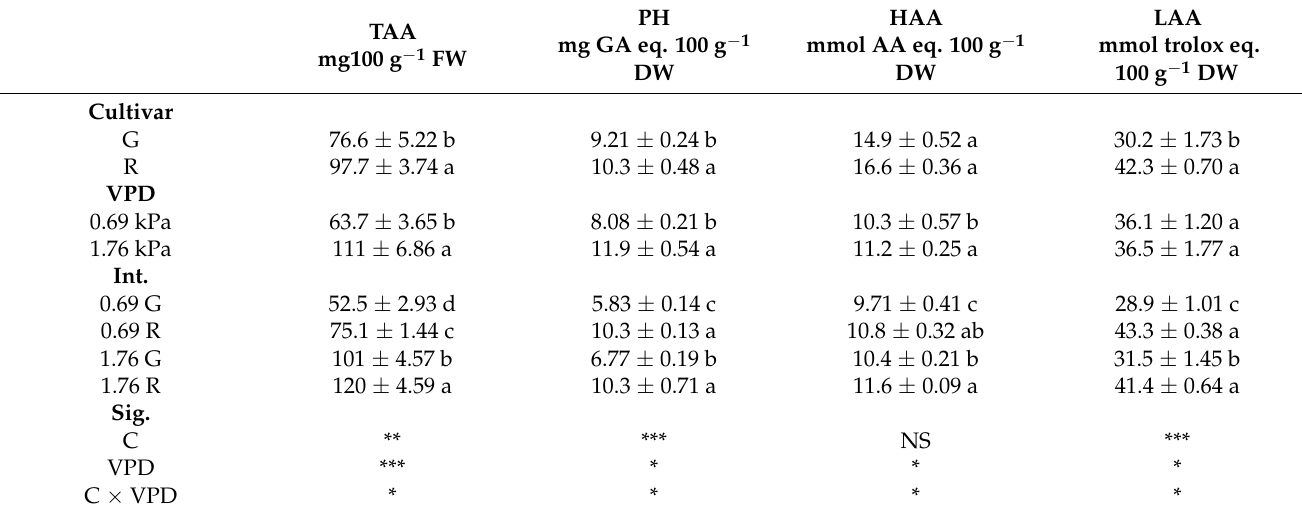
Table 4. Total Ascorbic Acid (TAA), Phenols (PH) , Hydrophilic antioxidant activity (HAA) and lipophilic antioxidant activity (LAA) in leaves of green (G) and red (R) lettuce plants grown under the two VPD levels (0.69 and 1.76 kPa). PH HAA LAA TAA mg GA eq. 100 g − 1 mmol AA eq. 100 g − 1 mmol trolox eq. mg100 g − 1 FW 100 g − 1 DW DW DW Cultivar